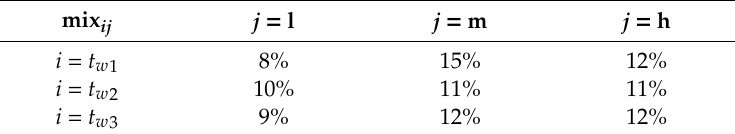
Table A3. A numeric example of Table A2.